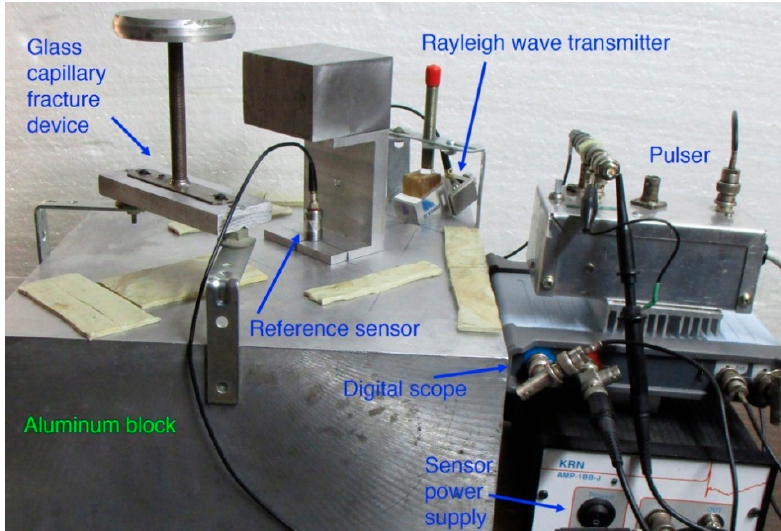
Figure 4. Photograph of Rayleigh wave calibration set-up (center) and a part of GC tube fracture set-up (left side). Rayleigh wave transmitter is placed at the back corner of the block and a reference sensor (under a steel block) is at 100 mm from the transmitter. Also shown are a pulser, a digital oscilloscope, a sensor power supply, and vibration damping strips.